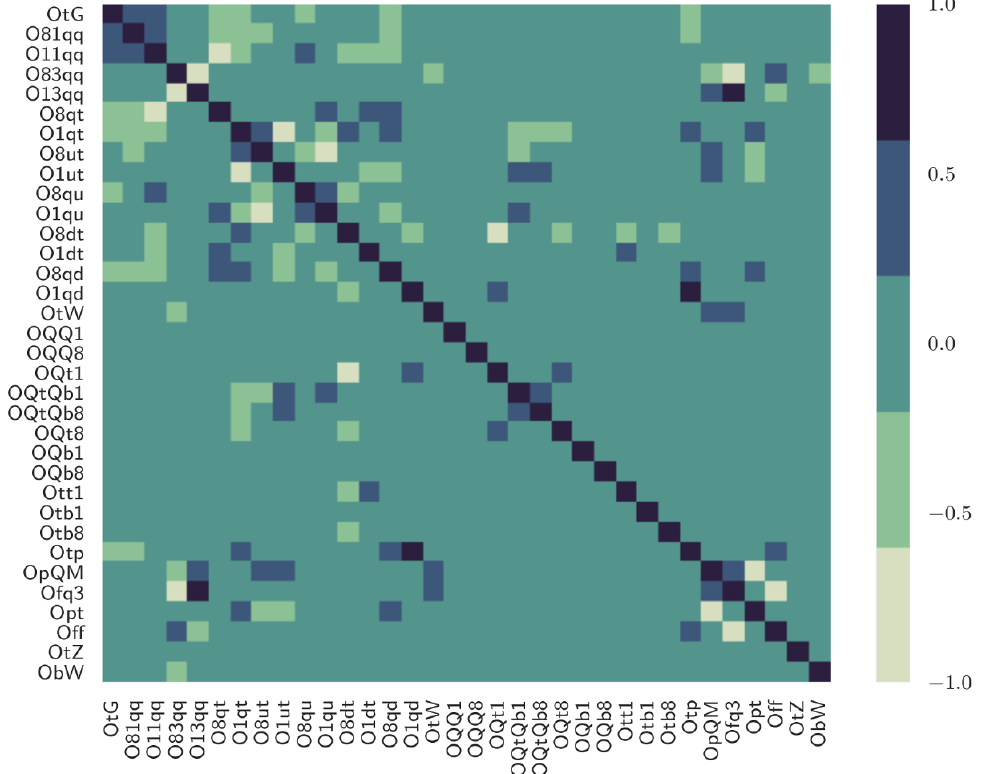
Figure 18 . Heat map indicating the values of the correlation coe(cid:14)cient (cid:26) ( c N op = 34 (cid:12)tted coe(cid:14)cients shown in (cid:12)gure 17, see text for more